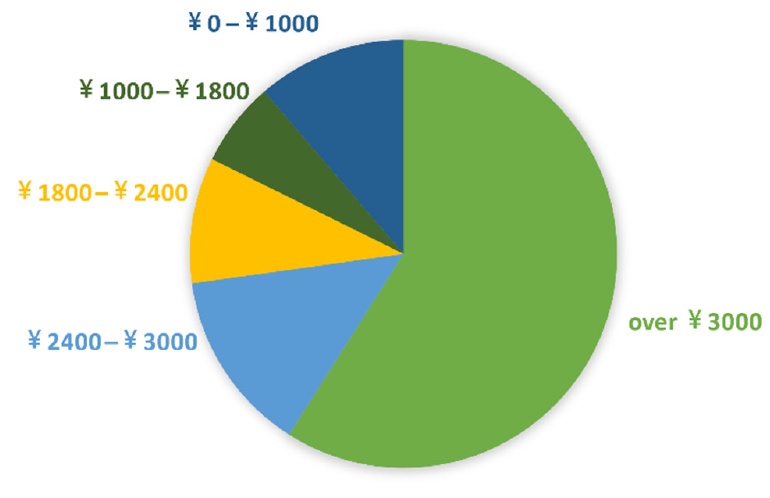
Figure 4. Distribution map of WTA.